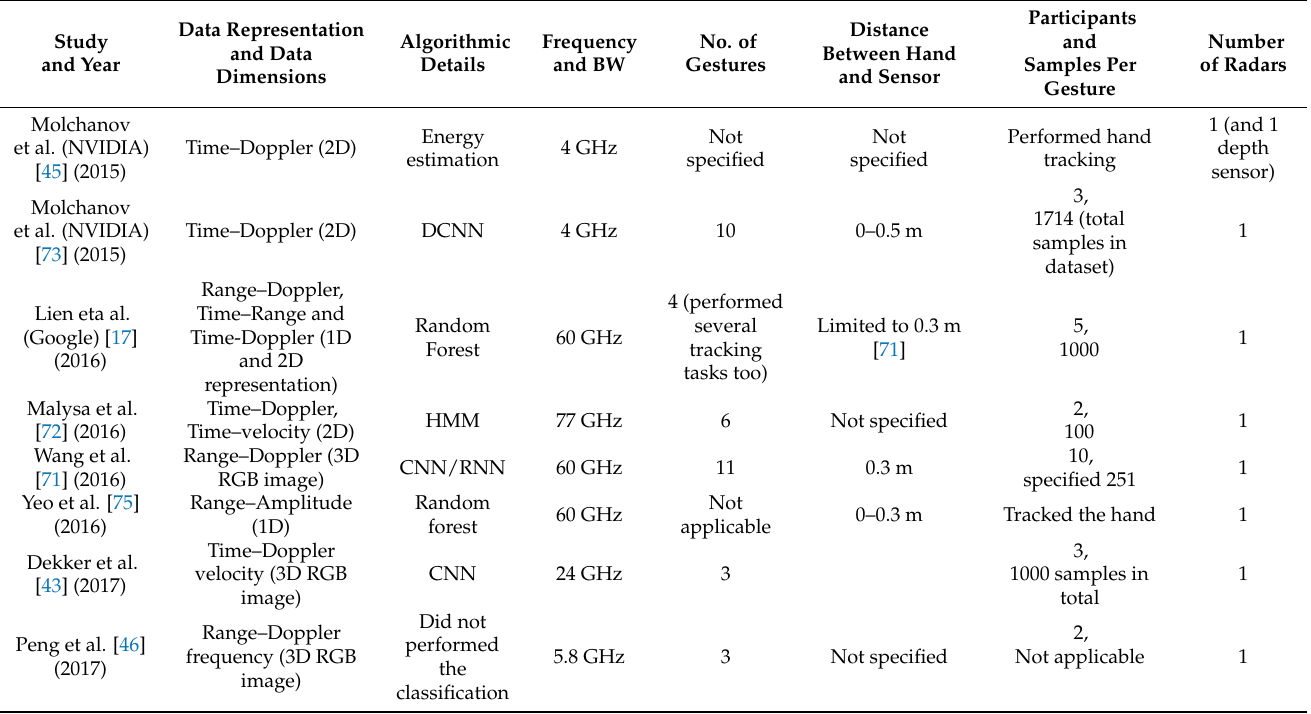
Table 5. Summary of HGR algorithms for FMCW